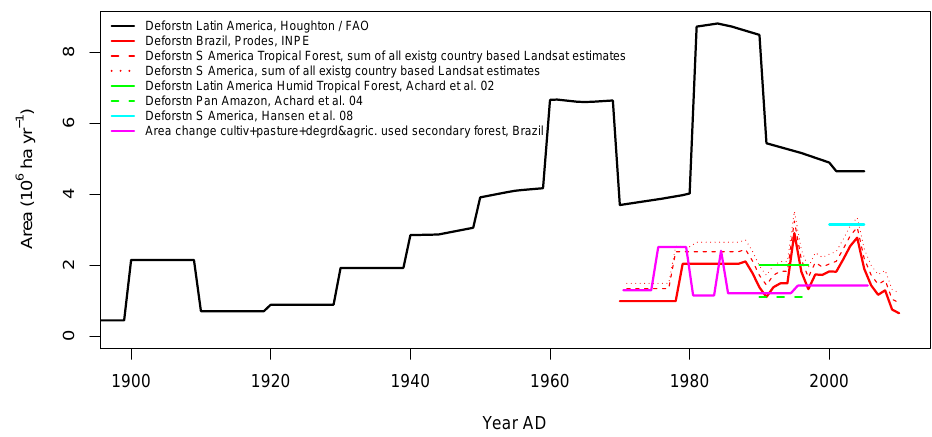
Fig. 7. Comparison of various estimates of annually deforested area in South America, tropical South America, and Brazil, and annual change in agriculturally used land in Brazil based on government statistics (AGROPECUARIA, same as in Fig. 3). The displayed estimates from top down are the following: (i) deforestation rate by area in South America according to FAO statistics (provided by R. Houghton in 2011), (ii) same but just for Brazil and estimated by INPE and Brazil based on Landsat images (PRODES, http://www.obt.inpe.br/prodes), (iii) same, based on PRODES and published studies of deforestation based on remote sensing (mainly Landsat) as listed in Table 4, (iv) same as (iii) but including in addition published remote sensing-based estimates for the rest of South America as listed in Table 4, (v) deforestation rate by area for Latin American humid tropical forests of Achard et al. (2002) based on remote sensing, (vi) same but for South America as estimated by Hansen et al. (2008), and (vii) total change in cultivated area per year due to agriculture in Brazil based on Brazilian government statistics (UNICA, http://www.unica.com.br/dadosCotacao/estatistica).